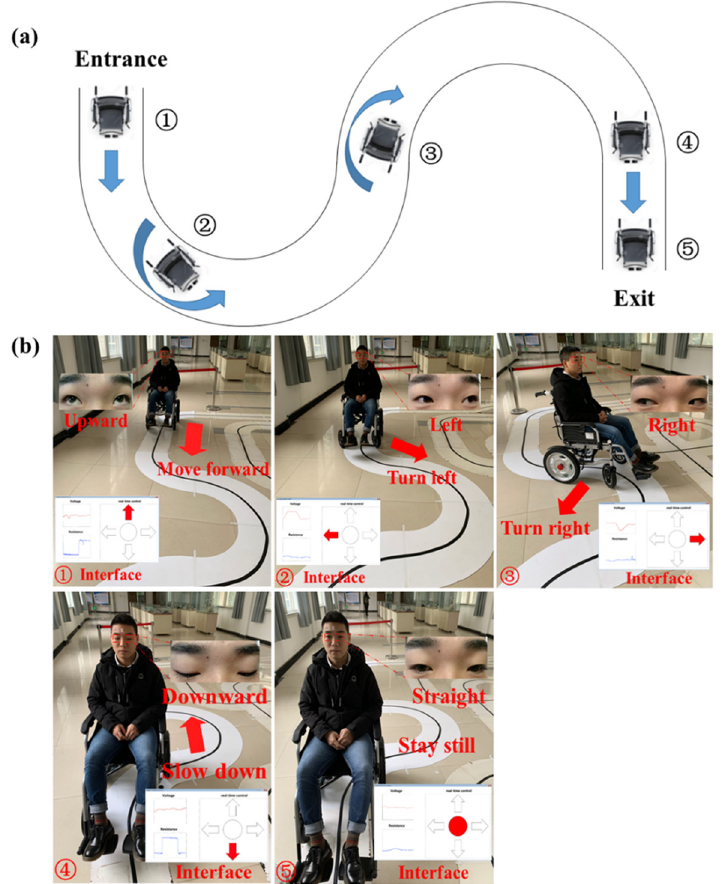
Figure 9. In-site experiment of eye movement-controlled wheelchair prototype. ( a ) Route map of the bend. ( b ) Diverse eye movement states and corresponding wheelchair movement modes.